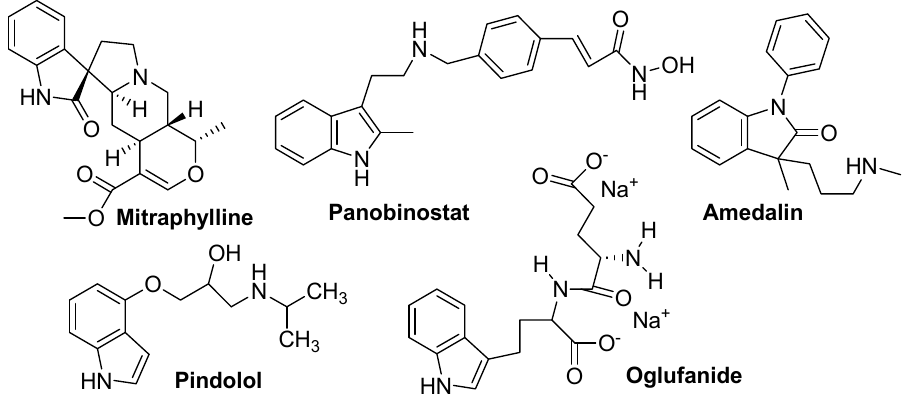
Figure 11. Mitraphylline as anticancer, panobinostat as antileukamic, amedalin as antidepressant, pindolol as antihypertensive , oglufanide as Immunomodulator .